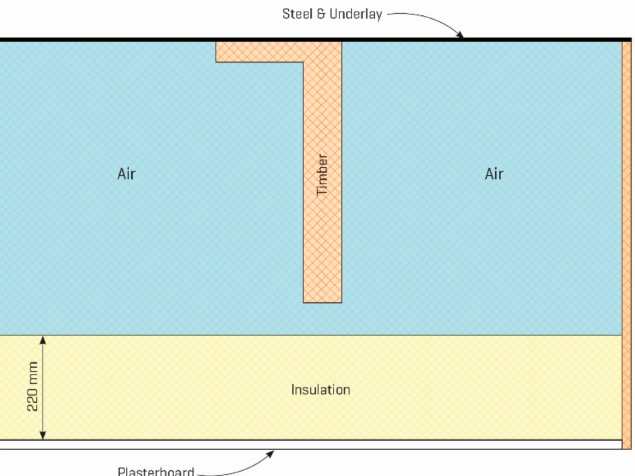
Figure 1. Geometry of the two-dimensional WUFI ® model of the roof space. A representative timber purlin is in contact with the cladding. The timber rafter/support structure is situated centrally in the air layer. The model is closed by thermal insulation and plasterboard at the bottom and two adiabatic side